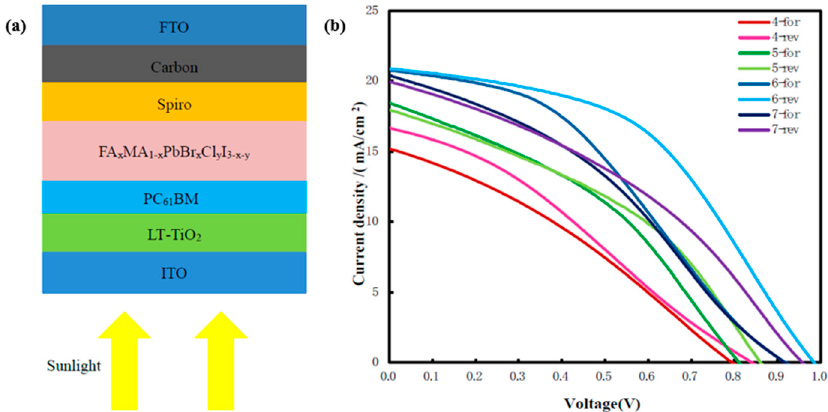
Figure 5. ( a ) Device structure diagram; ( b ) J–V curves of perovskite solar cells prepared with di ff erent Figure 5. (a) Device structure diagram; ( b) J–V curves of perovskite solar cells prepared with concentrations of formamidine methylamine halide precursor solution on ITO different concentrations of formamidine methylamine halide precursor solution on ITO substrate. Table 1. Performance parameters of perovskite solar cells prepared with different concentrations of formamidine methylamine halide precursor solution.